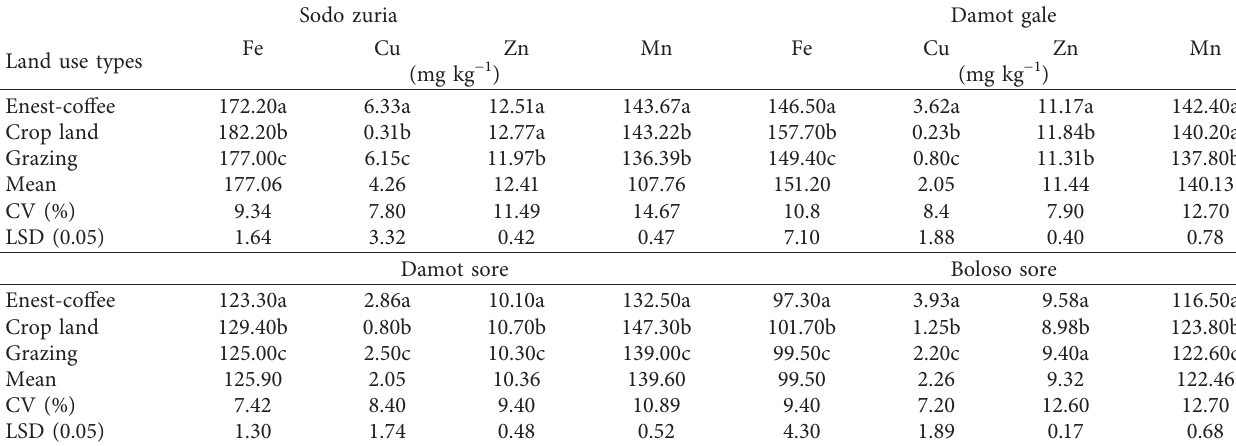
Sodo zuria Damot